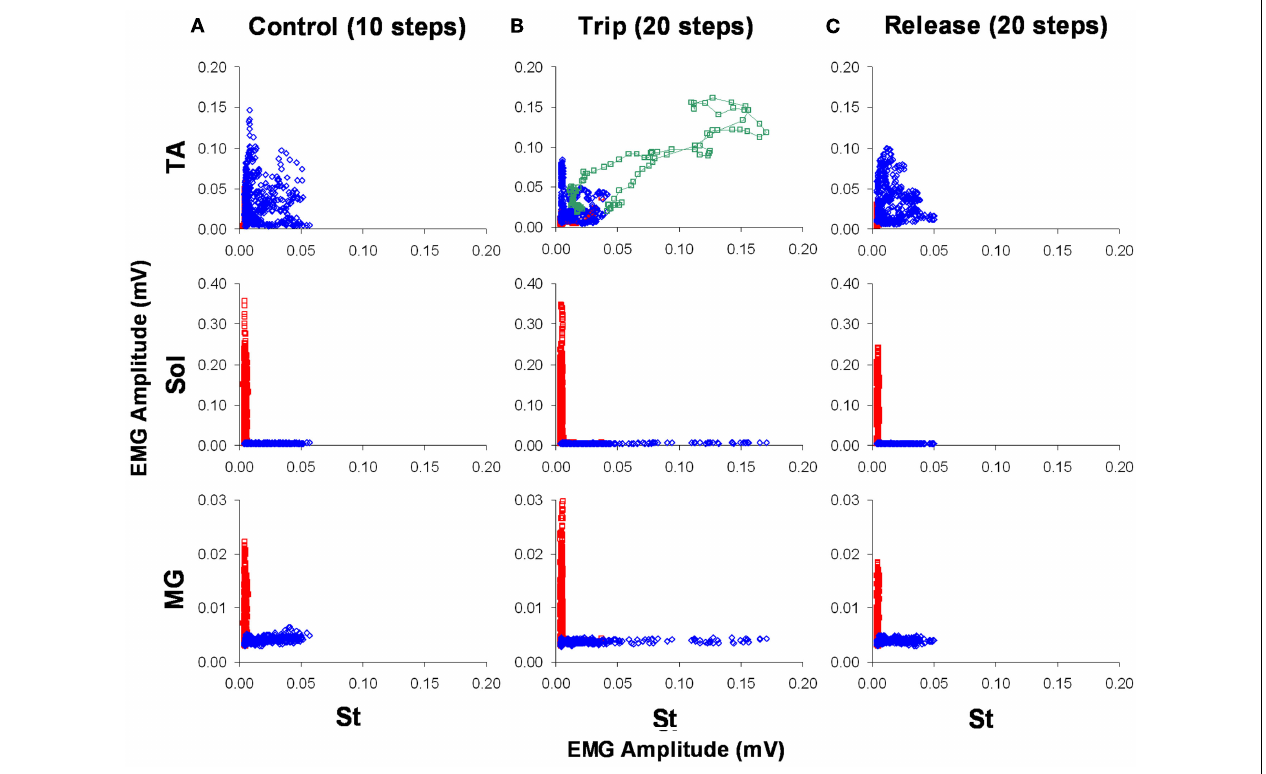
between theTA and St immediately after the trip.The data points are a five-point running average of the mean normalized EMG. Note the higher level of activation of the St during the trip compared to the control and release